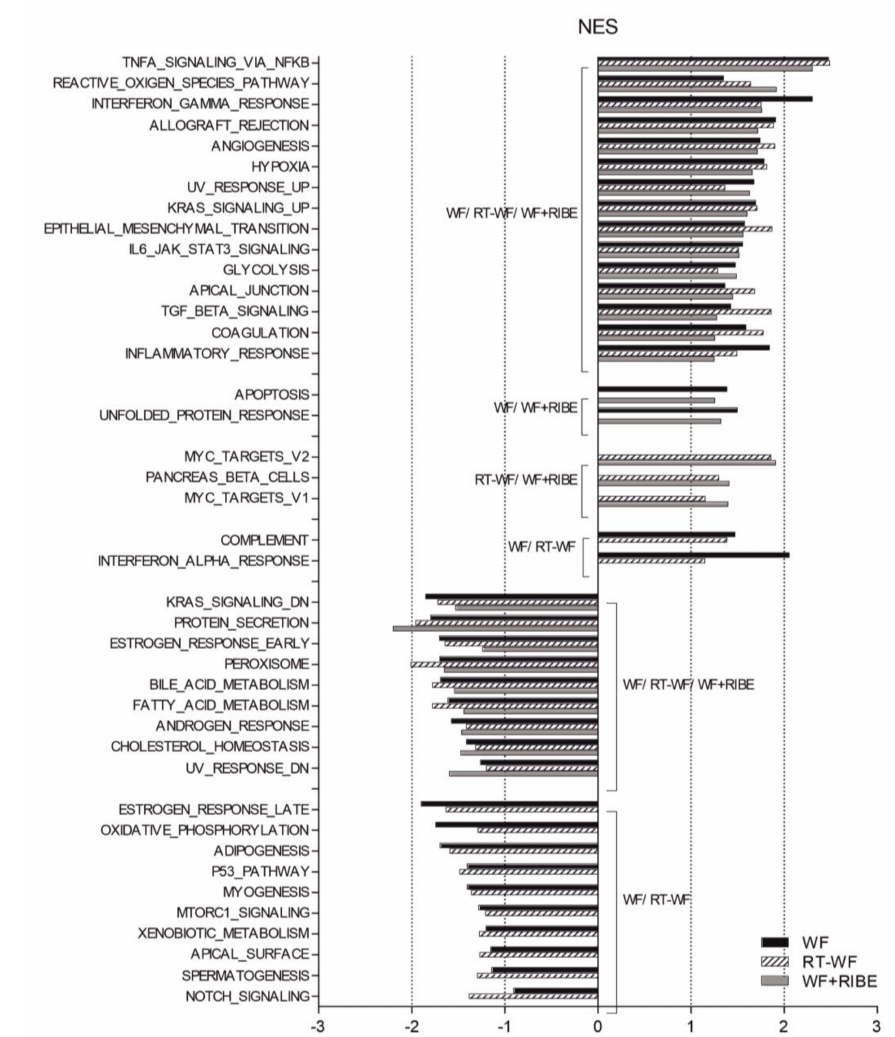
Figure 1. Breast cancer cells treated with surgical wound fluids are enriched in processes associated with tumorigenicity and metastatic potential. MDA-MB-468 cell lines were incubated with wound fluid (WF), radiotherapy wound fluid (RT-WF), and wound fluid with radiation-induced bystander e ff